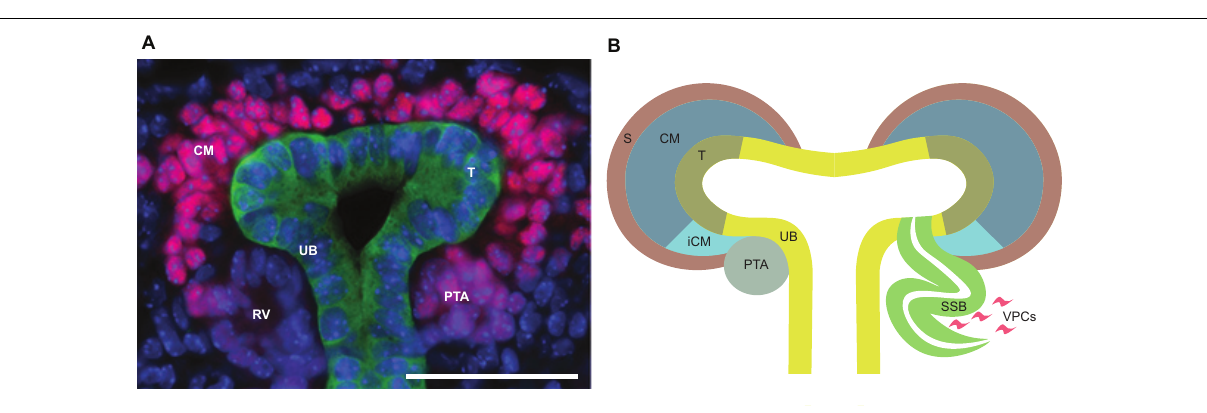
FIGURE 2 | (A) In vivo representation of developing kidney at embryonic day 15.5. SIX2 staining (pink) strongly localizes to the nephron progenitors in the cap mesenchyme (CM), while being less intensive in pretubular aggregate (PTA) and almost non-existent in renal vesicle (RV). Calbindin staining (green) highlights ureteric bud (UB) epithelium. Scale bar is 50 µ m. (B) Schematic depiction of nephrogenesis. The UB is segmented into molecularly-distinct tip (T, olive green) and stalk (UB, yellow) regions. UB tips are surrounded by CM (dark blue), including the nephron progenitors and the surrounding stroma (S, brown). A subset of the